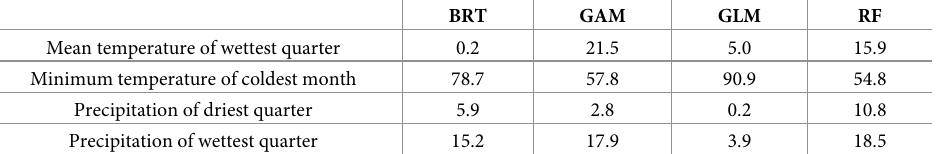
Table 2. Relative influence of predictor variables in models of climatic suitability for boosted regression trees (BRT), generalized additive models (GAM), generalized linear models (GLM) and random forests